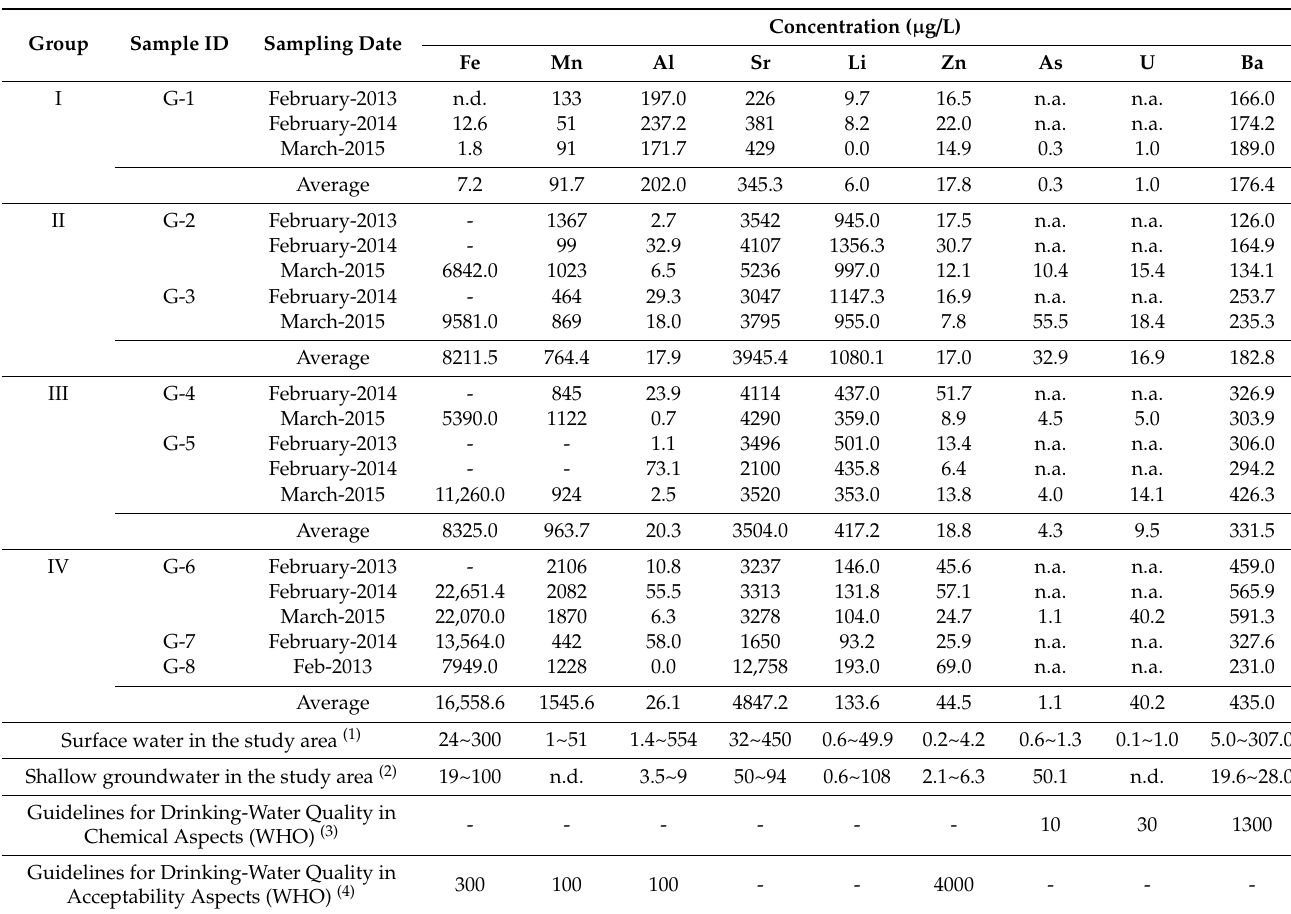
Table 2. Trace element concentrations of water samples from the CO 2 -rich springs in the northern part of the GSB. The CO 2 -rich springs are grouped based on pH, TDS and Na contents in Figure 2. Group I: dilute and acidic CO 2 -rich water; Group II: “Na-enriched” Ca-HCO 3 type water; Group III: “intermediate” Ca-HCO 3 type water; Group IV: “Na-depleted” Ca-HCO 3 type